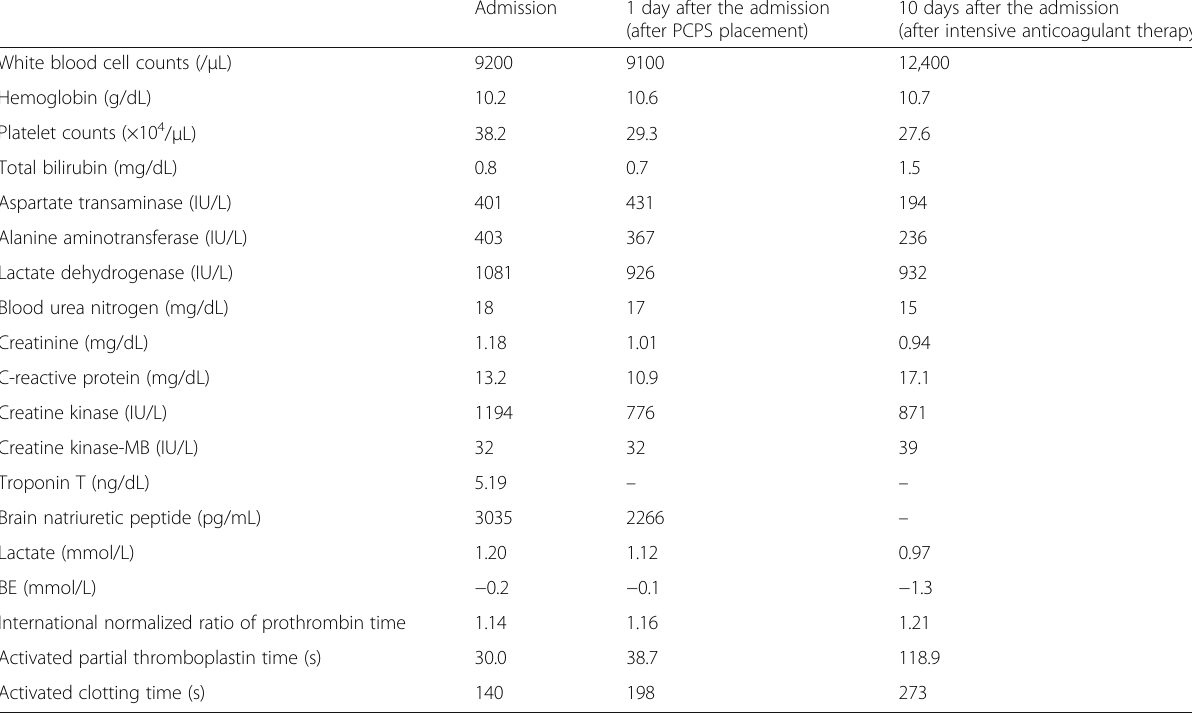
Table 1 The blood examination on admission and 1 and 10 days after the admission